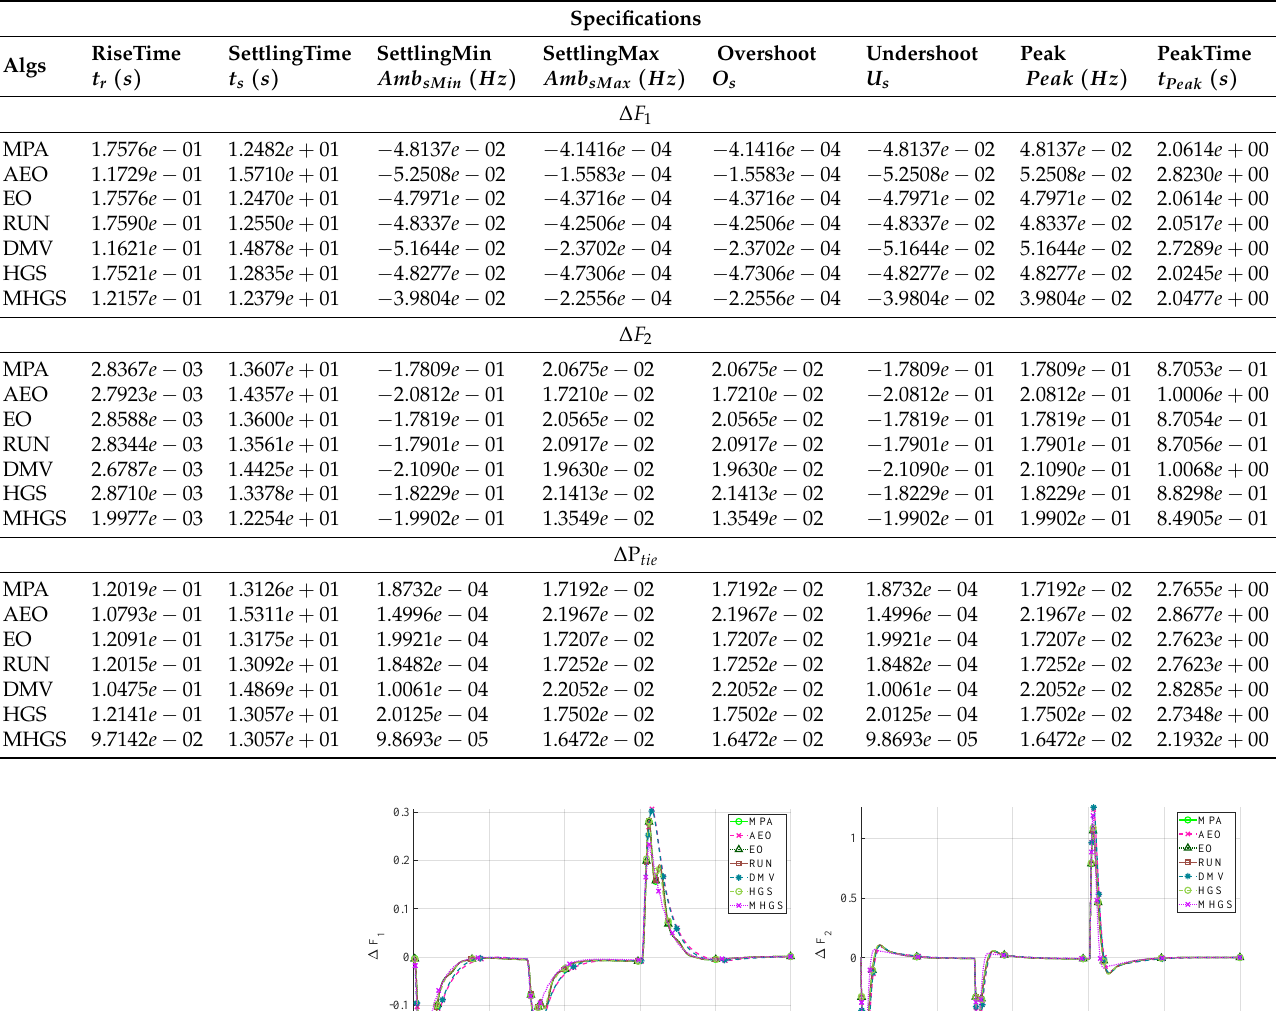
Table 2. Response properties of frequencies and tie-line powers’ fluctuations at 10% load disturbance in PV plant.